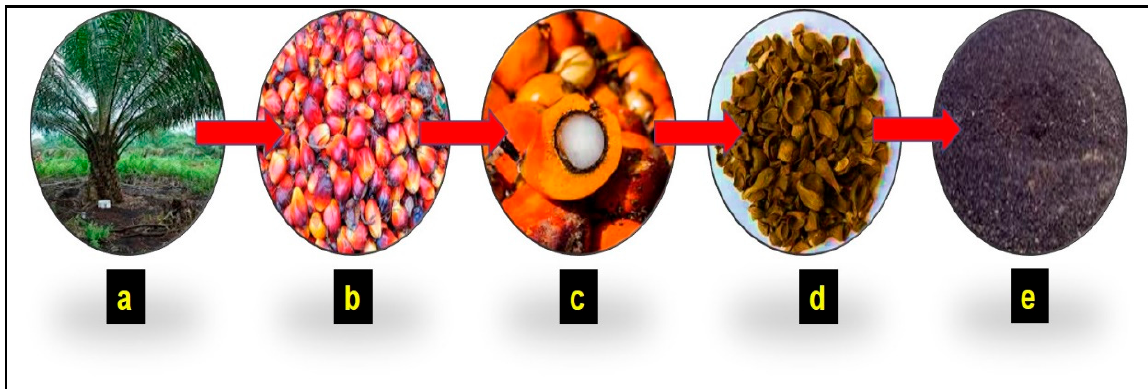
Figure 1. Extractions of OPS particles from palm tree. ( a ) Palm tree; ( b ) fruit; ( c ) kernel; ( d ) shell; ( e ) OPS filler.